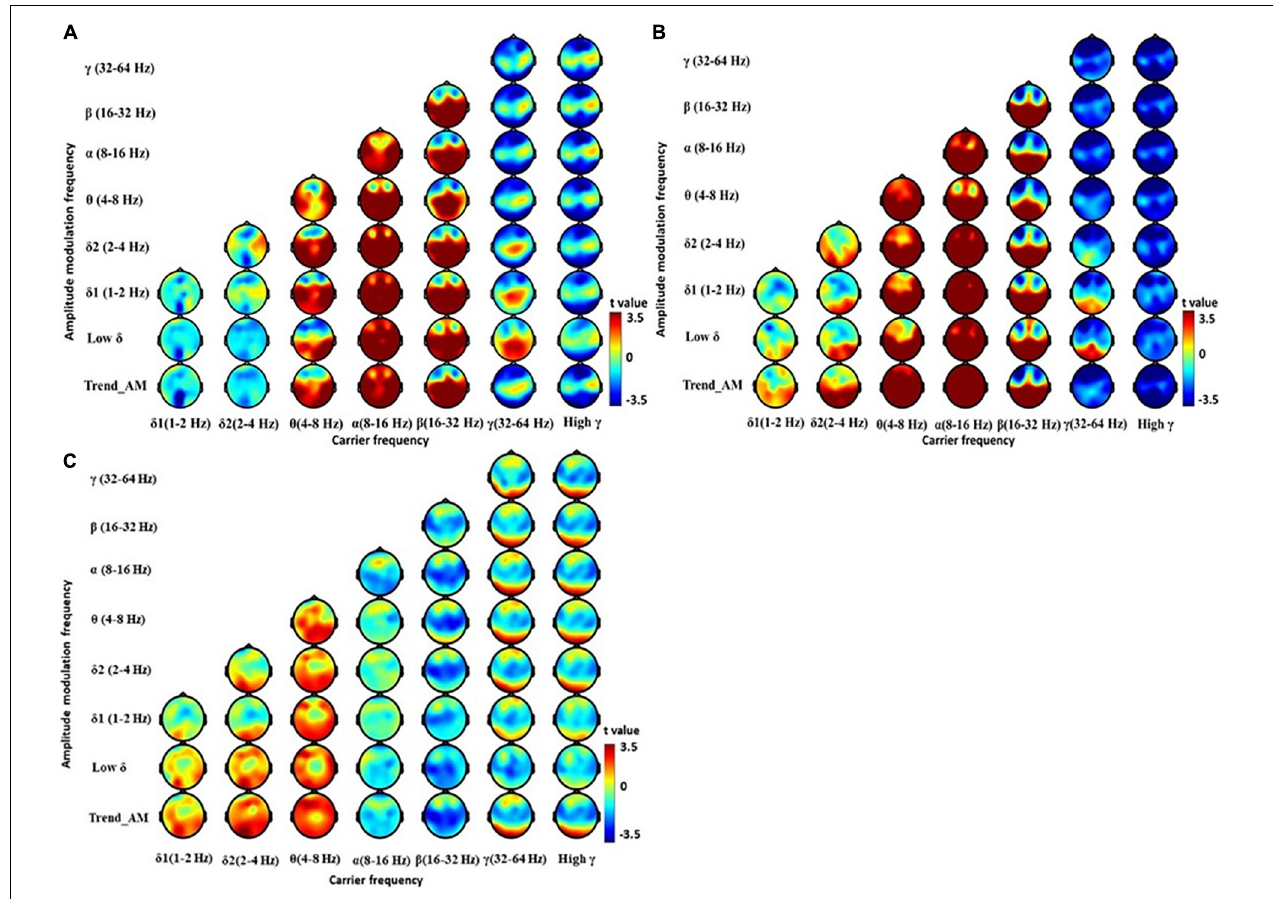
FIGURE 2 | Electroencephalography power difference between PD and HC using Holo-Hilbert Spectrum Analysis (HHSA). Holo-Hilbert topography (HHT) in the eyes-closed minus the eyes-open condition based on cluster-based non-parametric permutations in the (A) HC, (B) PD, and (C) PD minus HC. The color bar denotes t -statistics ranging from blue (–3.5) to red